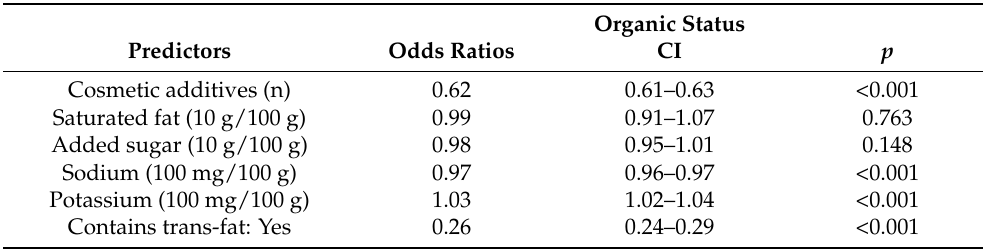
Table A4. Results from mixed logistic regression model of 8240 organic and 72,205 conventional products whereby missing nutrient values were assumed to be zero. This model included the parameter “cosmetic